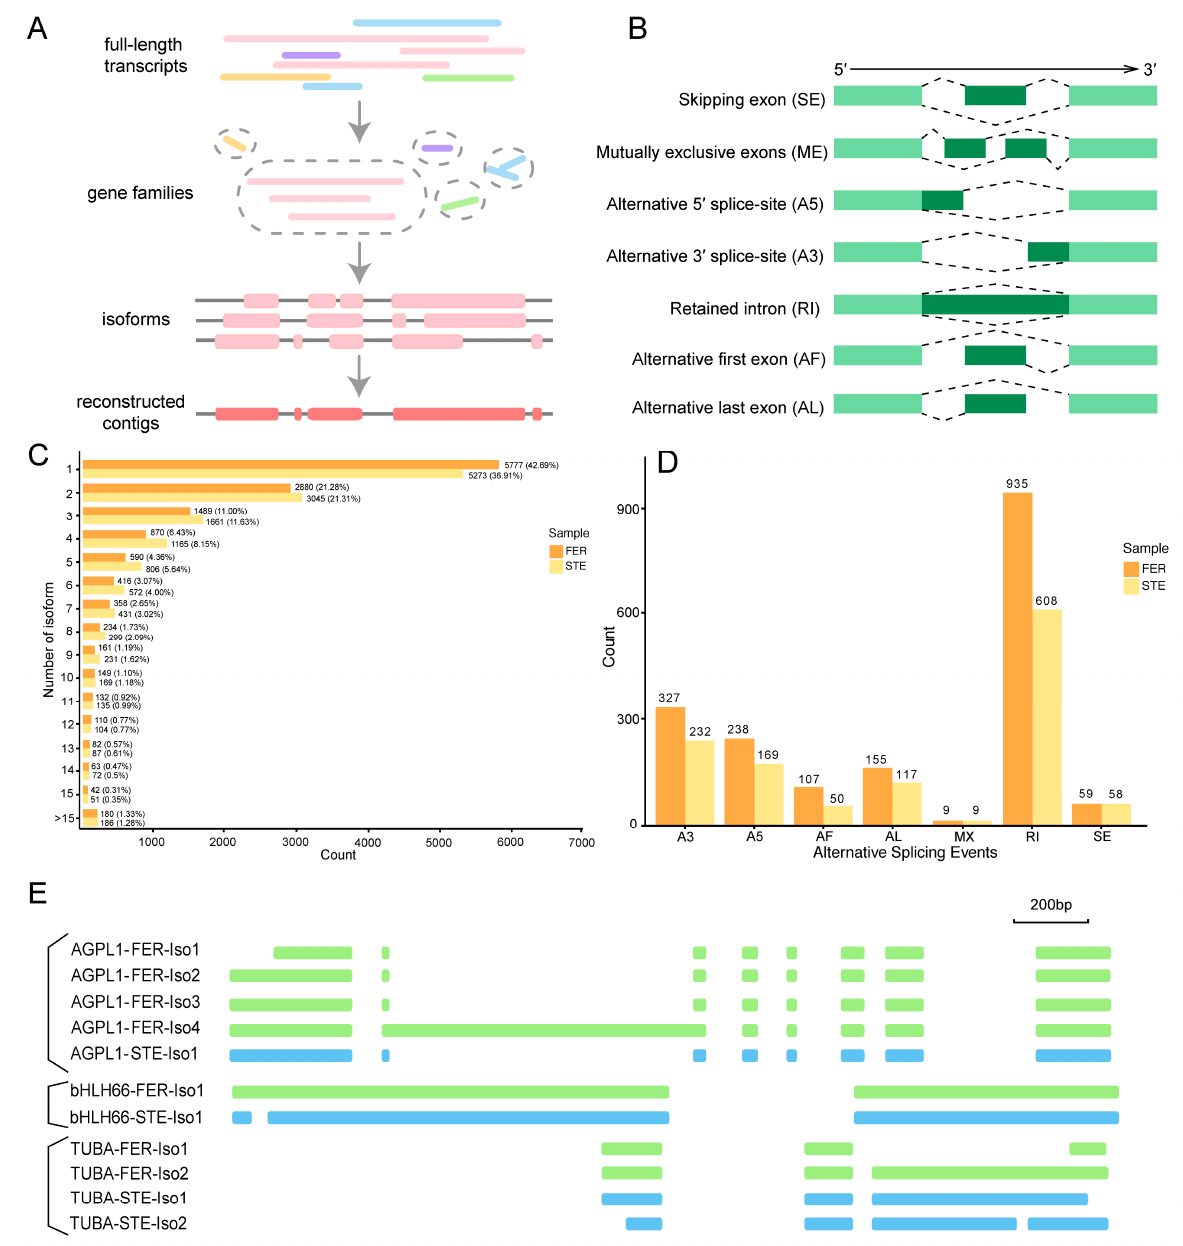
Figure 6. Comparison of different alternative splicing (AS) among FER and STE. ( A ) Schematic diagram of Cogent assembly; ( B ) visualization of seven AS modes; ( C ) distribution of isoform numbers in FER and STE; ( D ) different types of AS events in FER and STE; ( E ) the model graph shows AGPL1/bHLH66/TUBA generating different transcript isoforms of RI detected in two tissues. A3: alternative 3 ′ splice-site; A5: alternative 5 ′ splice-site; AF: alternative first exon; AL: alternative last exon; MX: mutually exclusive exons; RI: retained intron; SE: skipping exon.